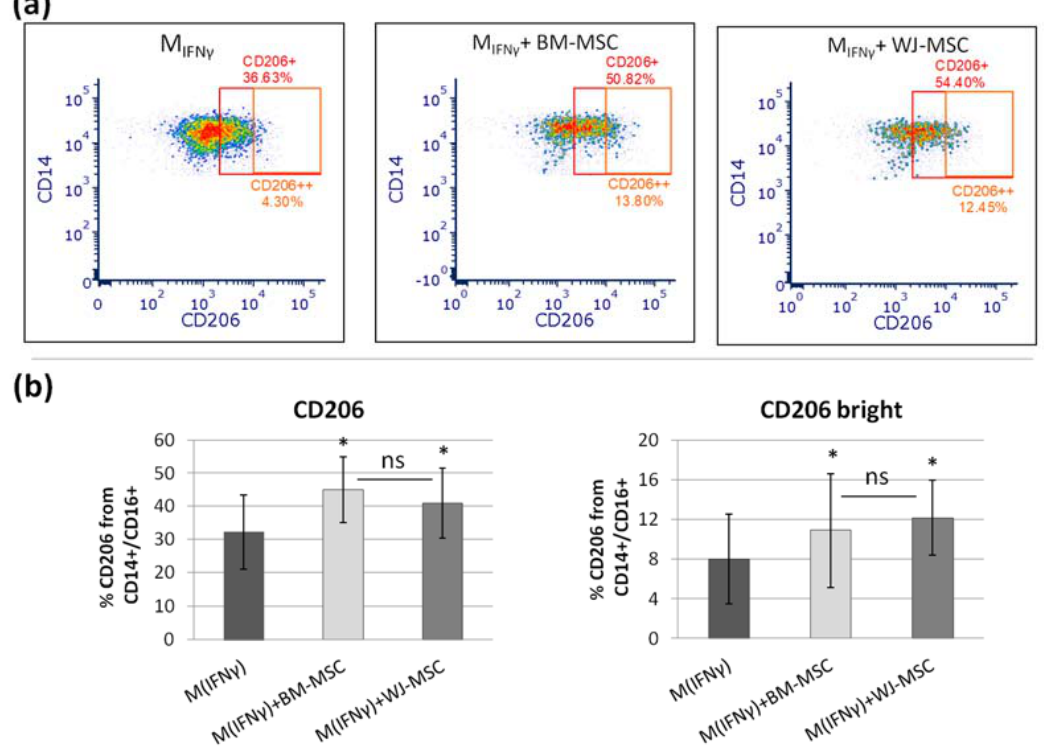
Figure 5. The effect of BM-MSCs and WJ-MSCs on the differentiation of macrophages. The graph shows the results of the flow cytometry analysis. ( a ) Representative density plots illustrating the expression of CD206 antigen on IFN γ -stimulated macrophages (M IFN γ ) and the same macrophages after addition of bone marrow (BM) mesenchymal stromal cells (MSCs) and Wharton jelly (WJ)-MSCs. Numbers above gates indicate percentage (%) of cells positive for CD206, and numbers below gates indicate percentage of cells with strong expression of CD206 (CD206++). ( b ) The mean ( ± SEM) expression of CD206 (and CD206++) of M IFN γ cultured in monoculture and in co-culture with BM-MSCs and WJ-MSCs. The effect of different types of MSCs on M IFN γ analyzed using Wilcoxon test in comparison to the same macrophages cultured in monoculture, * p < 0.05, n = 8. The normality was checked using the Shapiro–Wilk test. The comparison of effect of the different types of MSCs was determined as the difference (“ ∆ ”) between CD206 expression after co-culture with MSCs with and the expression without the addition of MSCs, and then the “ ∆ ” values for both types of MSCs were compared as independent data (U Mann–Whitney test). ns—statistically not significant. For this assay, macrophages from 6 PBMC donors were used. Every population was paired in parallel with BM-MSCs and WJ-MSCs populations; WJ-MSCs from 4 donors and BM-MSCs from 5 donors were